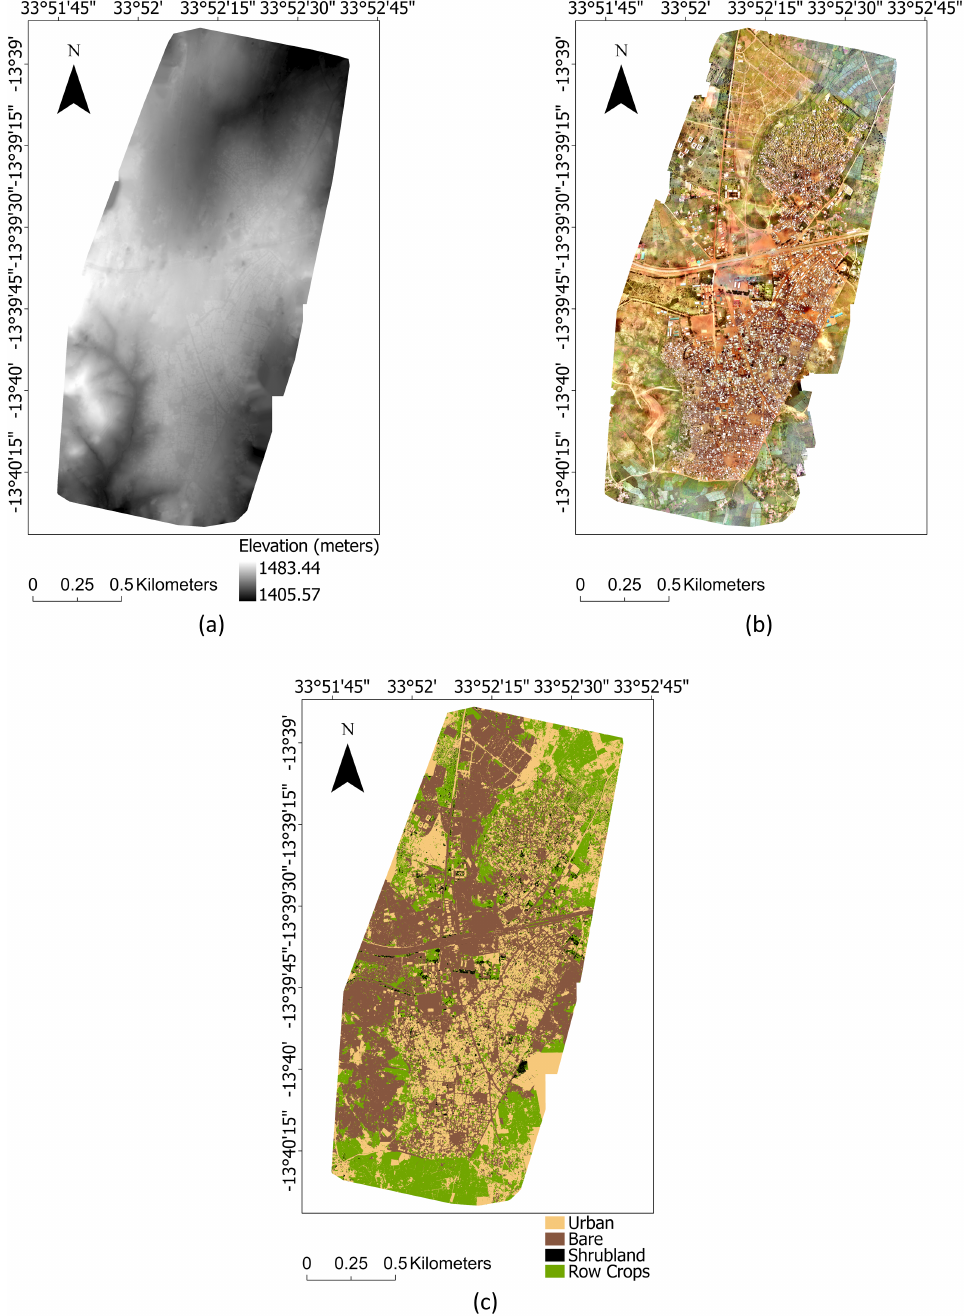
Figure 11. ( a ) Digital terrain model (DTM), ( b ) orthomosaic, and ( c ) land use map. The DTM and land-use maps were created by stitching 2603 images of Dzaleka Refugee Camp together in Pix4D Mapper. The land-use map was created by using ArcGIS Object Classification on the orthomosaic (Figure 11b). The study area contains four different land classifications: urban (tan), bare (brown), shrubland (black), and row crops